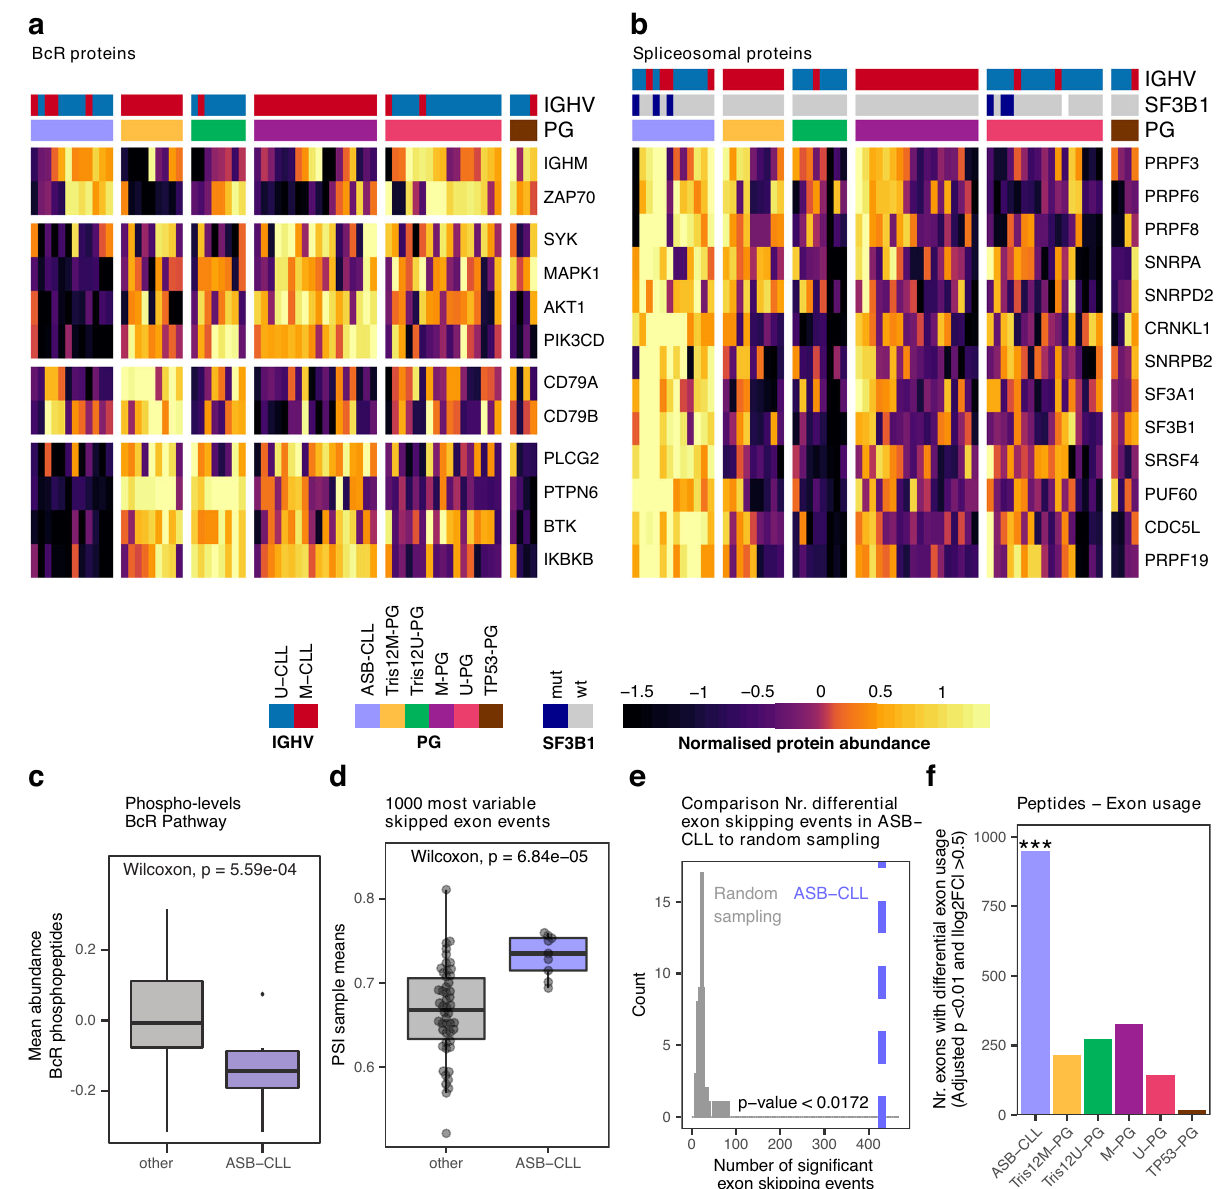
Fig. 5 | Characterization of the new proteomics group ASB-CLL. a Heatmaps of scaled log2 protein abundances for selected BcR proteins and b spliceosome components. Patients were grouped according to PG and the proteins were clus- tered hierarchically. Based on these pro fi les the group “ New-PG ” was renamed to “ ASB-CLL ” ( A ltered S pliceosome, low B cR signaling proteins CLL ) c The mean relative intensity of phosphorylated peptides uniquelymapping to proteins whose correspondinggenesbelongtothegeneset:KEGG_B_CELL_RECEPTOR_SIGNALING and whichcouldbequanti fi ed in atleast 50% of TMT-channelswerecalculated per sample.12biologicallyindependentASB-CLLpatientsampleswerecomparedto56 other biologically independent patient samples. d Mean percent spliced-in (PSI) value per patient calculated from the 1000 most variable exon skipping